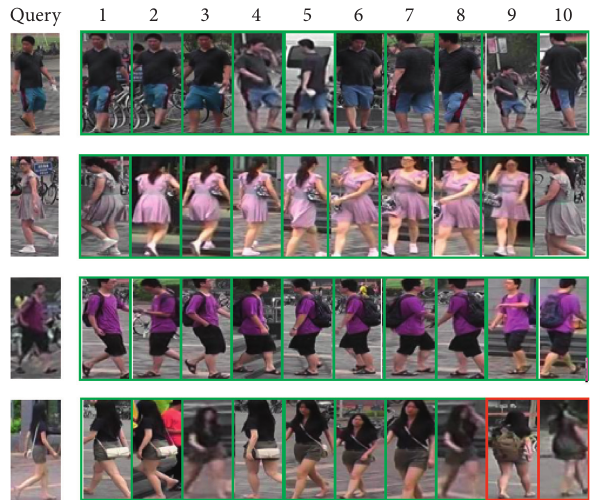
Figure 9: Top-10 ranking list for some query images on Market- 1501 Figure 9. Figure 9 mainly shows the matching results of the images in Ranks-1–10. The green box indicates that the image matches the Gallery library image correctly, belonging to the same ID, and the red box indicates the matching error.